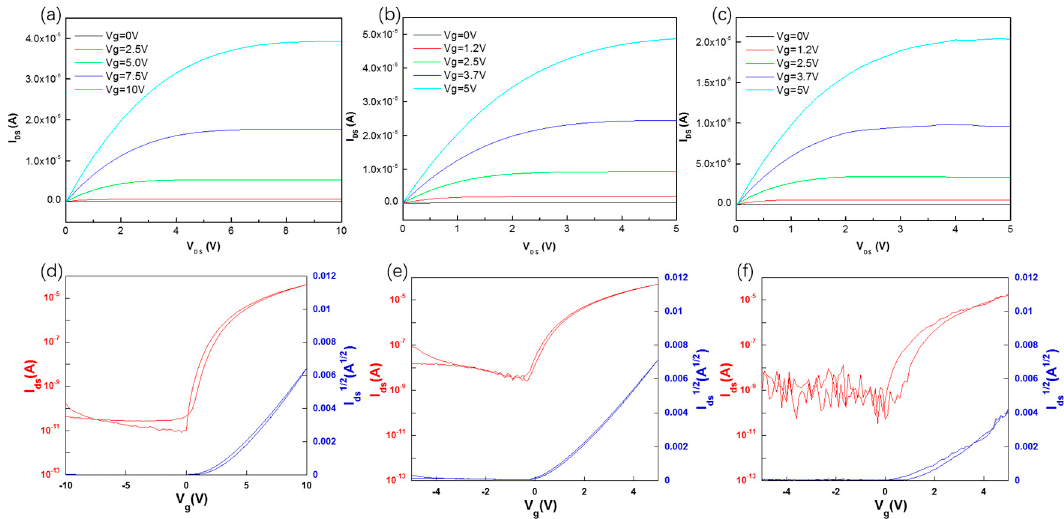
Figure 9. Output characteristics of ( a ) 0.6 M ZrO 2 -TFT coated three times; ( b ) 0.3 M ZrO 2 -TFT coated three; and ( c ) 0.3 M ZrO 2 -TFT coated six times; transfer characteristics of ( d ) 0.6 M ZrO 2 -TFT coated three times; ( e ) 0.3 M ZrO 2 -TFT coated for three; and ( f ) 0.3 M ZrO 2 -TFT coated six